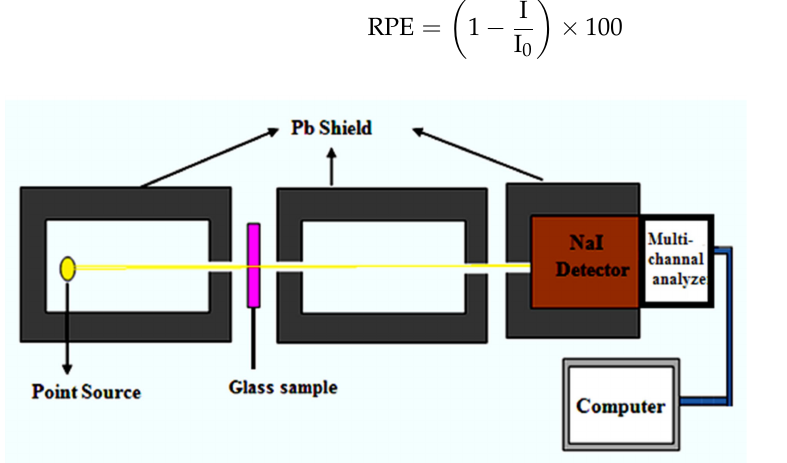
Figure 2. Experimental